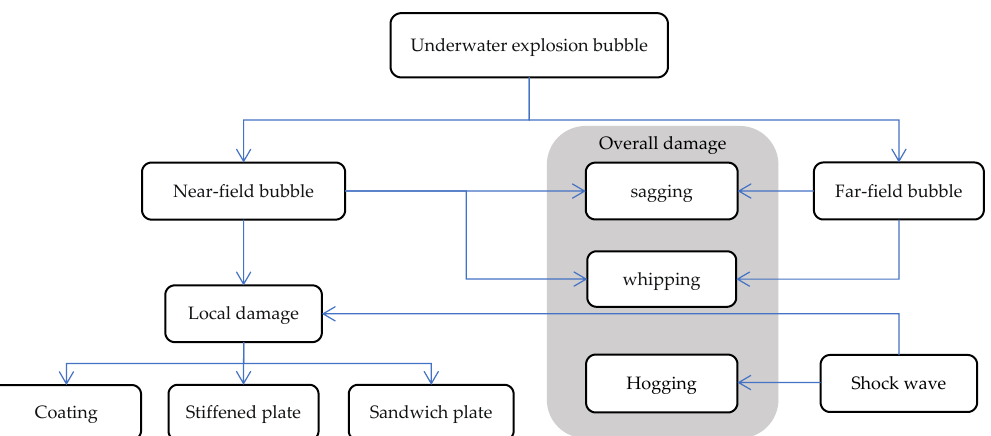
Figure 1. Underwater explosion ship damage summarized in the